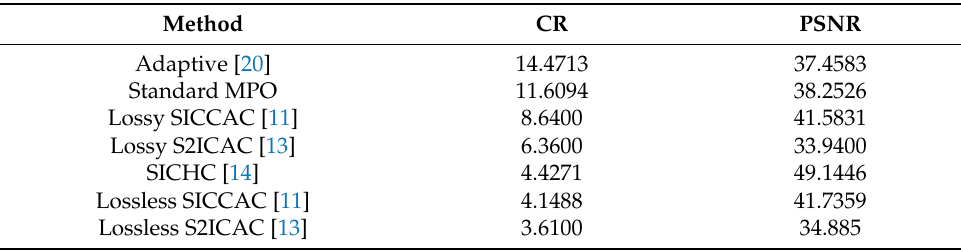
Table 7. Compression Ratio (CR) and average PSNR of the evaluated methods on the LIVE 3D dataset